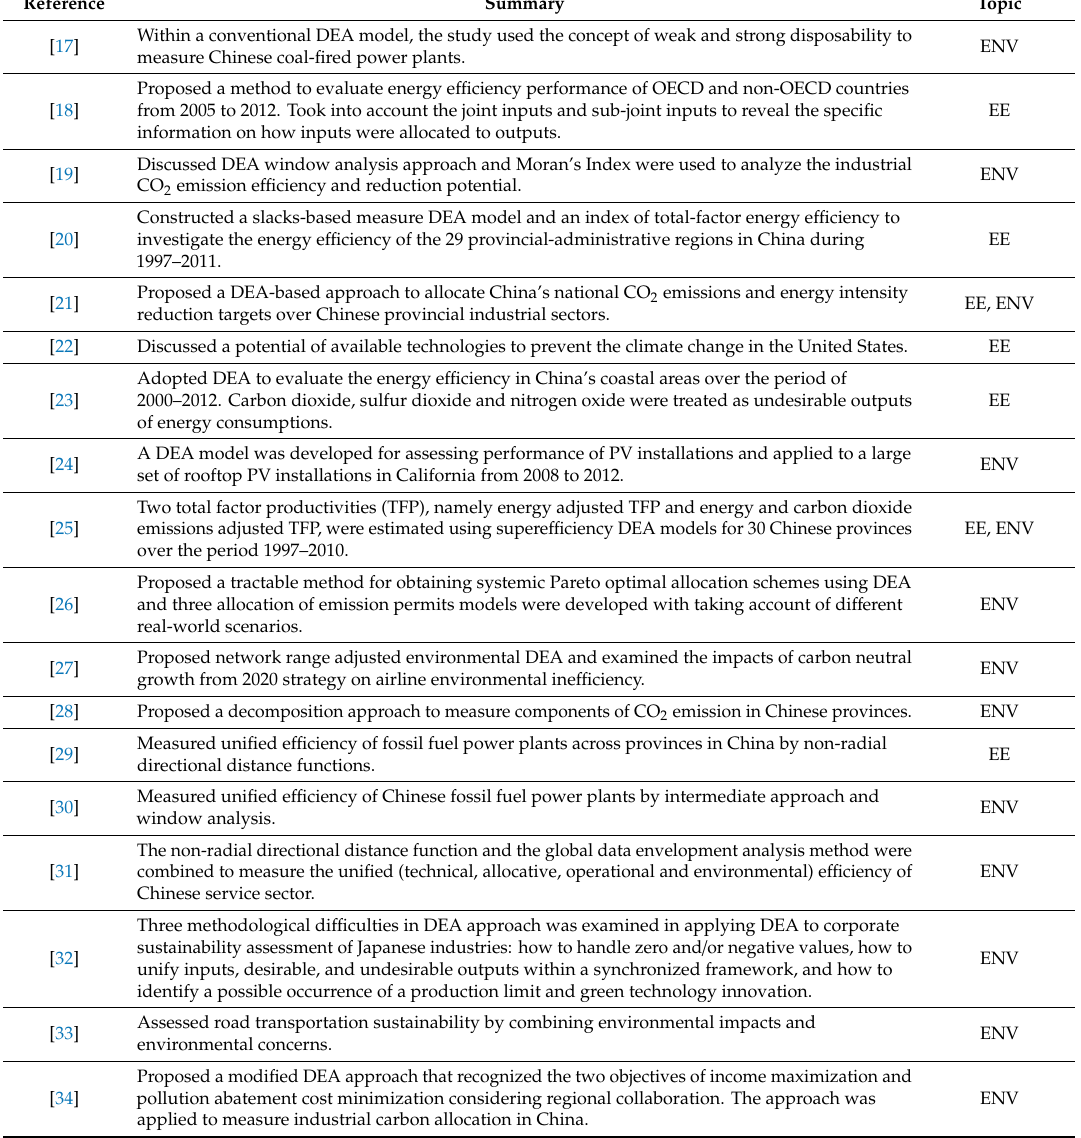
Table 1. Recent Studies on DEA Applied to Energy and